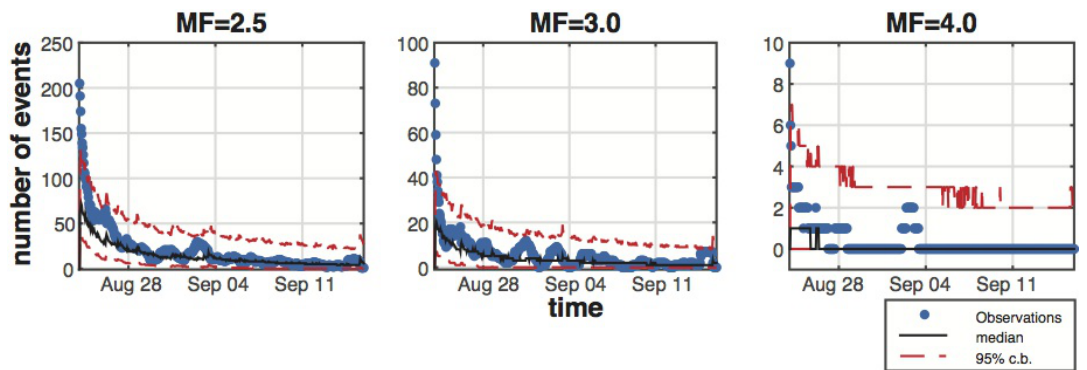
Figure 2: Comparison between the observed and the expected number of events for the threshold forecast magnitude M F = 2.5, 3.0 and 4.0 for the first 20 days of the sequence (Aug 24 -Sep 15)